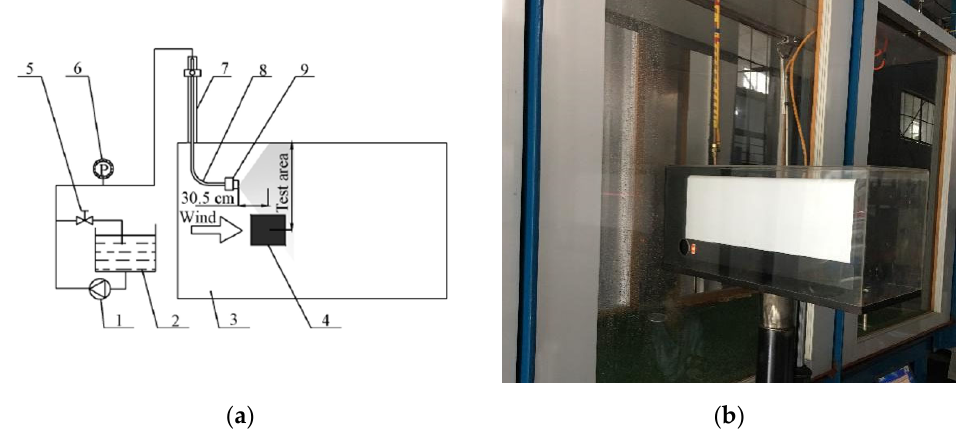
Figure 1. Droplet size test system.1. Liquid pump 2. Water tank 3. NJS ‐ 1 wind tunnel 4. DP ‐ 02 laser particle size analyzer 5. Pressure regulating valve 6. Pressure gauge 7. Lifting rail 8. Spray boom 9. Nozzle. ( a ) Schematic diagram of test system; ( b ) Physical map of the test system